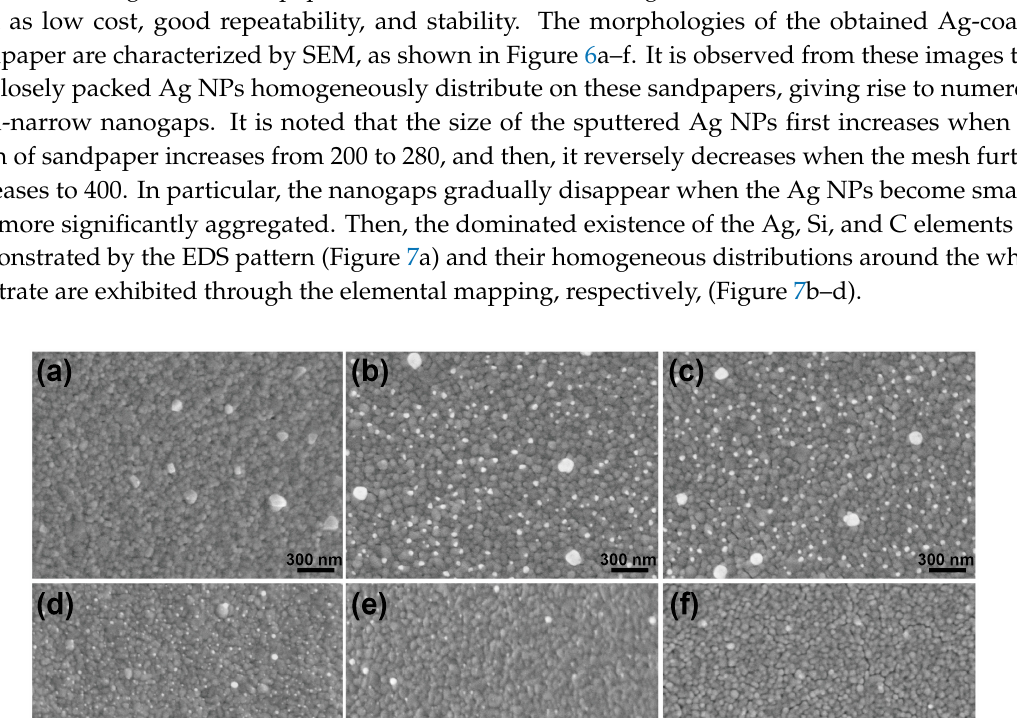
Figure 5. ( a ) The photocatalytic mechanism of Fe 3 O 4 @TiO 2 @Au nanocomposites; ( b ) Absorption